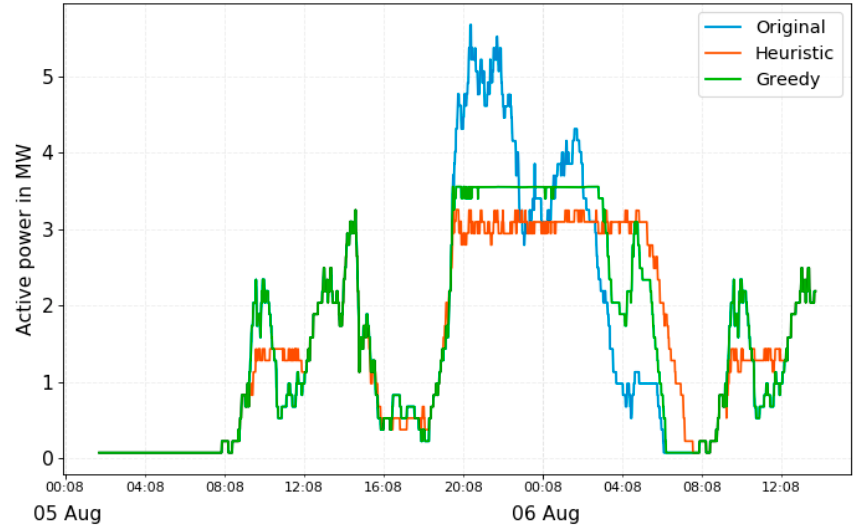
Figure 12. Load profile resulting from the original, heuristic and greedy schedule in the summer months, with no preconditioning and the ambient temperature of 28 °C.